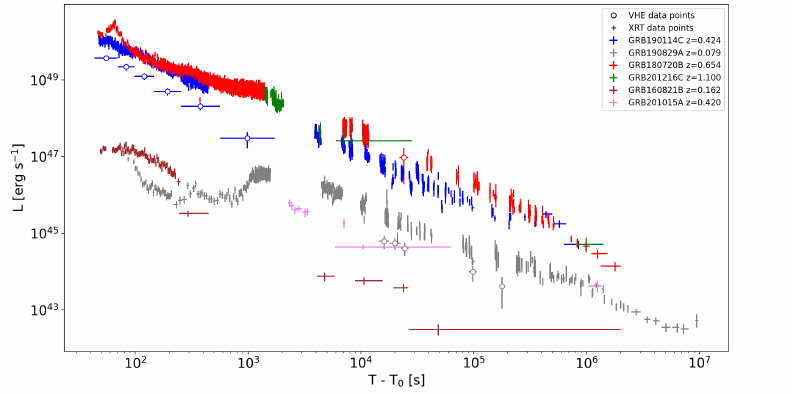
Figure 29. X-ray and VHE luminosity versus rest-frame time for the six GRBs detected in the TeV domain. The X-ray light-curve in the 0.3–10 keV energy range is taken from the Swift Burst Analyzer webpage 8